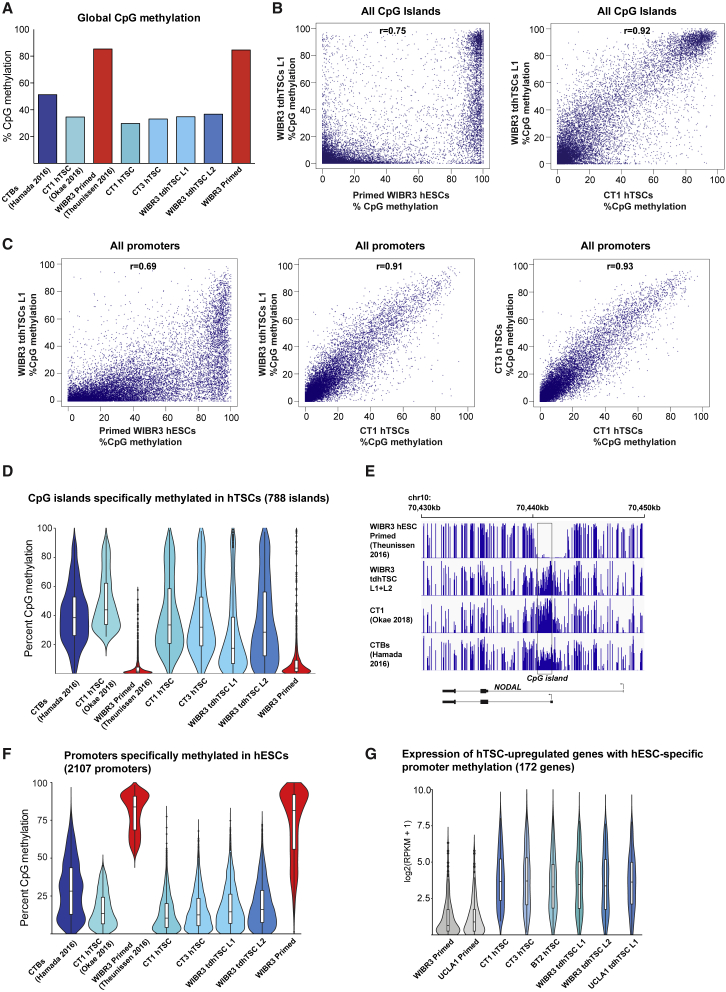
Global Methylation Patterns of tdhTSCFor all data, data in parentheses indicate data mined from published sources, data without parentheses indicate original data.(A) Global CpG methylation level in samples indicated.(B) Correlation of CpG island methylation in each of the two samples is indicated. Each CpG island represents as a single point, all CpG islands with adequate coverage are plotted.(C) Correlation of promoter methylation between two samples is indicated. All autosomal promoters with adequate coverage are plotted.(D) Violin plot indicating degree of CpG island methylation in samples indicated among 788 CpG islands that show higher DNA methylation in CT1 hTSCs relative to primed hESCs.(E) DNA methylation of a region of genome that includes the CpG island promoter of NODAL. Height of bars corresponds to percentage CpG methylation, from 0% to 100%. Data from WIBR3 tdhTSC L1 and L2 are merged to allow sufficient sequencing depth for visualization.(F) Violin plot showing methylation level of 2,107 promoters that show higher DNA methylation in primed hESCs relative to CT1 hTSCs.(G) Expression of 172 possible “gatekeeper” genes, genes that have upregulated expression in hTSCs and higher promoter methylation in hESCs. Expression of each gene, using an average of all replicates for a given cell type, is indicated as a single point on the violin plot. Box indicates 25th, 50th, and 75th percentiles. n = 2 (all tdhTSC lines), n = 3 (UCLA1 hESCs), n = 4 (WIBR3 hESCs, CT3, BT2), n = 7 (CT1) biological replicates.